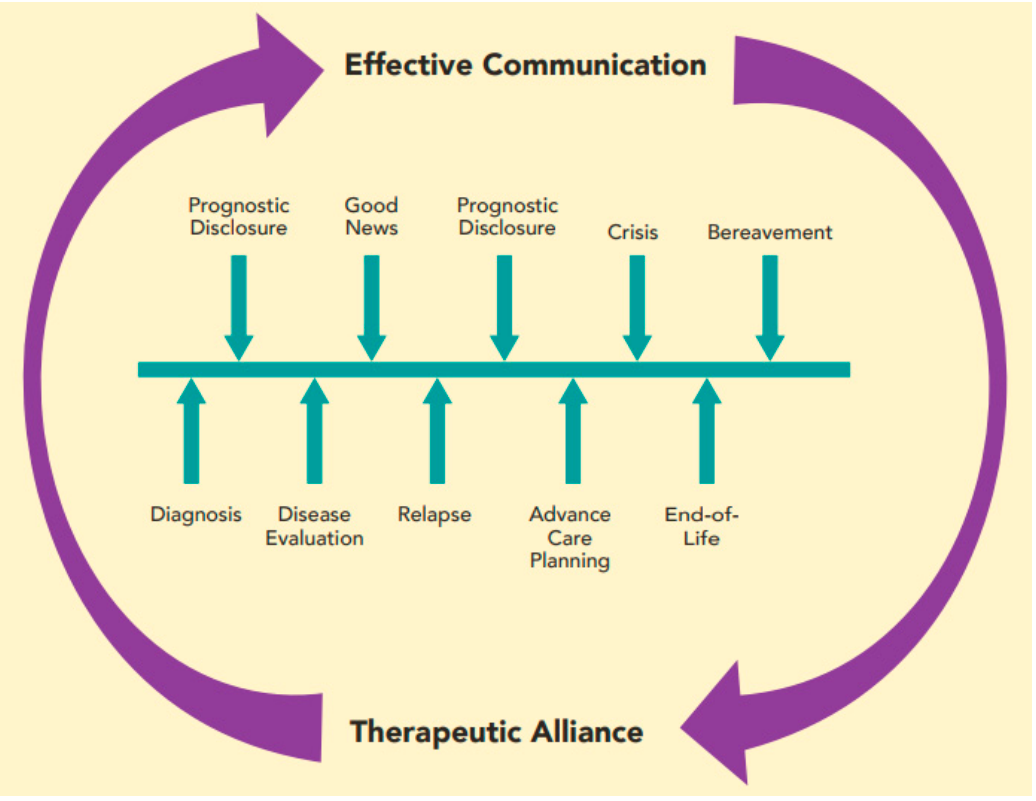
Figure 1. Diagram of the cyclic, reinforcing relationship between effective communication and therapeutic alliance throughout illness trajectory.